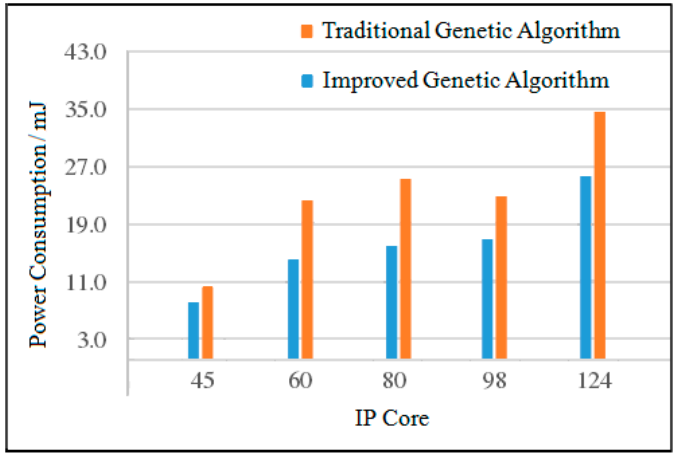
Figure 17. Comparison of the maximum power consumption of the two algorithm. (3)